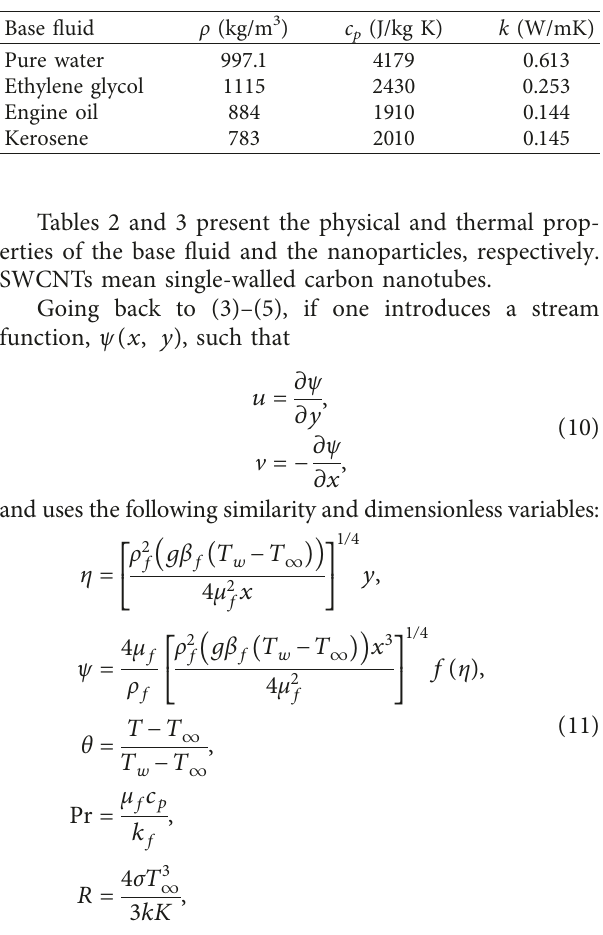
Table 2: Physical and thermal properties of the base fluid [41,